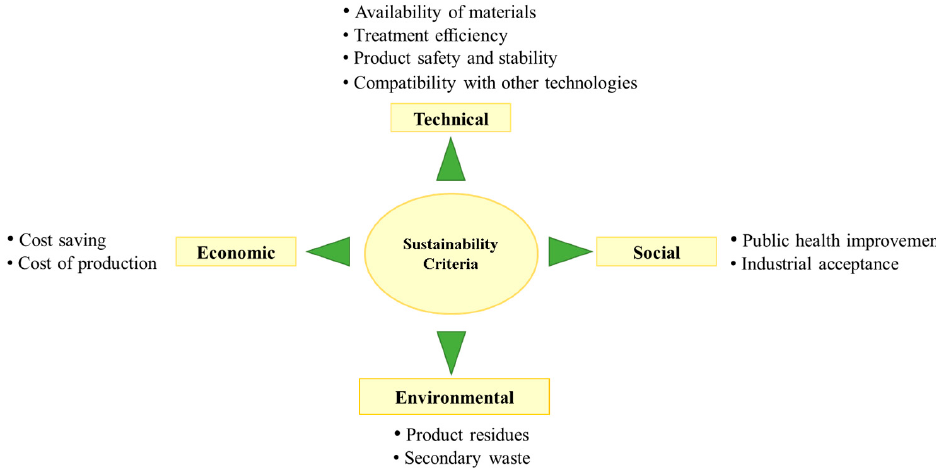
Figure 2. Sustainability criteria of natural coagulants.